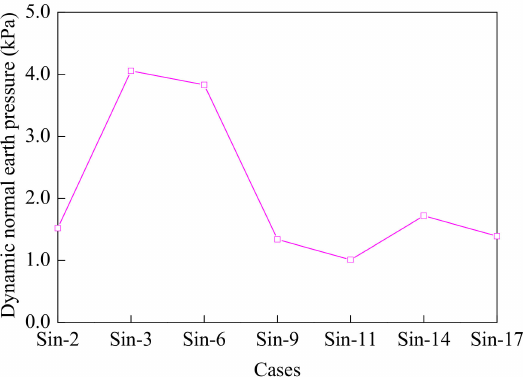
Figure 27. Maximum dynamic earth pressures under different cases.